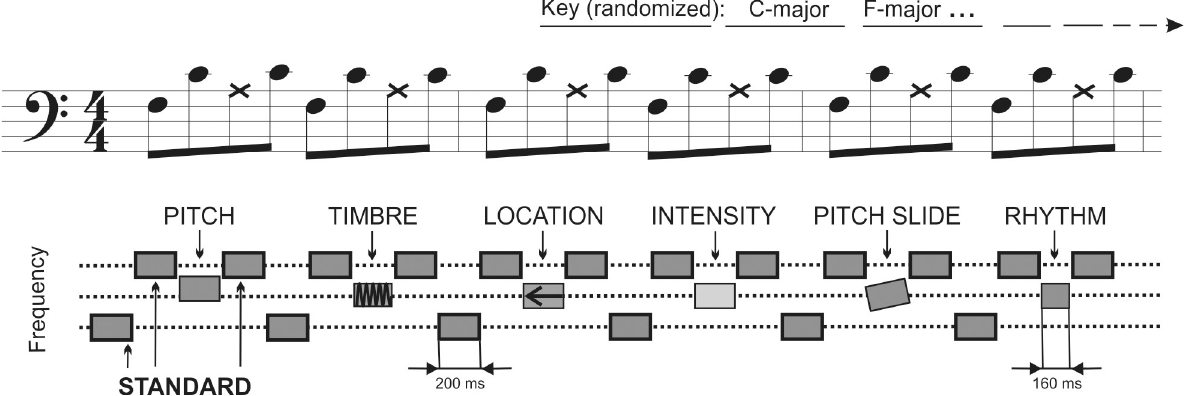
Fig 1. Stimuli. “Alberti Bass” played with piano tones in notation (top row) and schematic (bottom row) depiction. Each tone was 200 ms with an ISI of 5 ms. Each pattern of four notes includes deviant sound at the 3 rd position (X notes on the figure). Deviant order is randomized. The patterns are transposed to a different key every six bars, going through all major and minor keys during the